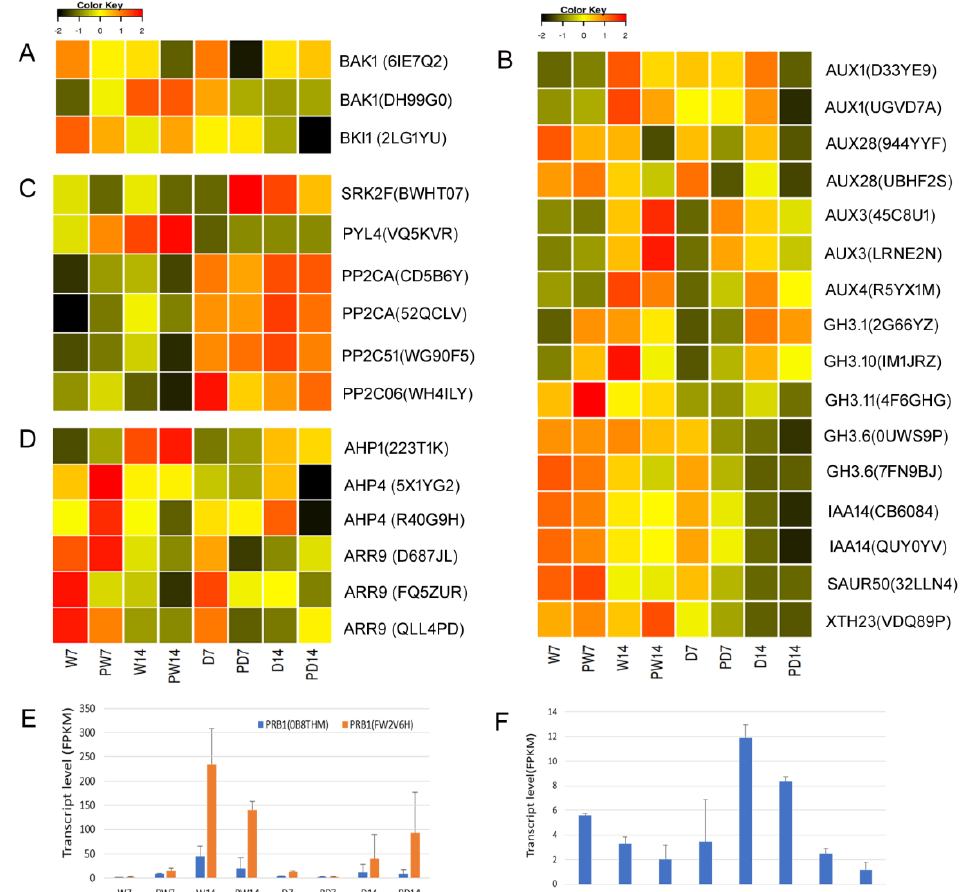
Figure 8. Expression patterns of DEGs in hormone signaling pathways under well-watered and drought conditions. Expression change of differentially expressed genes with at least two-fold changes and p < 0.05 in hormone signaling pathways of (A ) Brassinosteroid (BR), ( B ) auxin, ( C ) abscisic acid (ABA), ( D ) cytokinin, ( E ) salicylic acid (SA), and ( F ) jasmonate (JA). Expression levels were calculated in fragment per kilobase per million reads (FPKM) from triplicate experiments. Heatmap shows the normalized value Z-score after log 2 (FPKM) transformation. W7, PW7, W14, PW14, D7, PD7, D14, and PD14 represents the samples, where 7, 14, W, D, and P represent 7 days of treatment, 14 days of treatment, well-watered condition, drought condition, and seed priming with BR, respectively. The DEG’s id is shown inside a parenthesis. Abbreviations for DEG encoding proteins of AUX/IAA: auxin-responsive protein IAA; GH3: auxin responsive GH3 family; XTH: xyloglucan endotransglucosylase/hydrolases; SAUR: small auxin-up RNA gene family; BAK: BRI1-associated receptor kinase 1; BKI: BRASSINOSTEROID INSENSITIVE 1; SRK2: serine/threonine-protein kinase domain SRK2 subgroup 3; PYL: abscisic acid receptor 1 of PYR/PYL family; PP2C: clade A protein phosphatase 2C; AHP: histidine-containing phosphor-transfer protein; ARR: type-A Arabidopsis response regulator; PRB1: pathogenesis-related protein 1 like; JAZ: JASMONATE ZIM-DOMAIN protein.